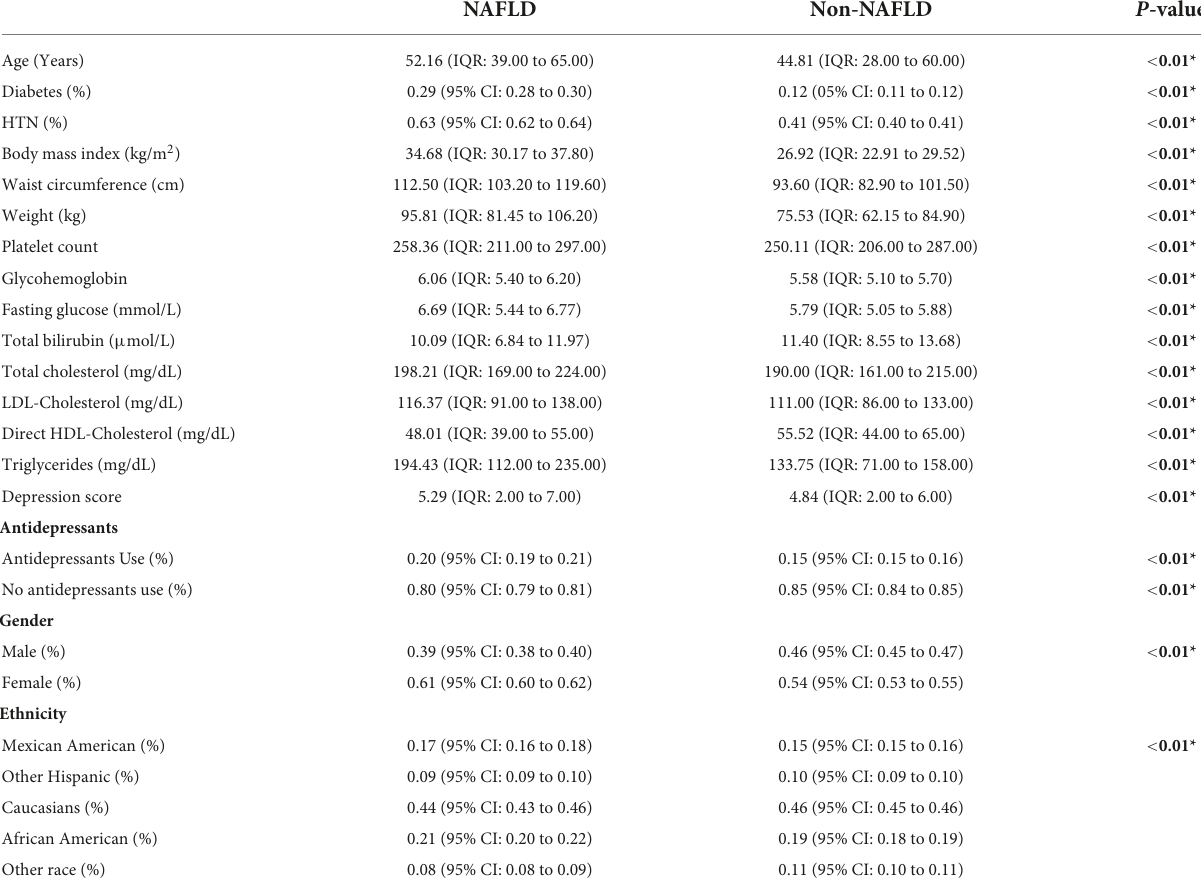
TABLE 1 Summary of baseline characteristics of included